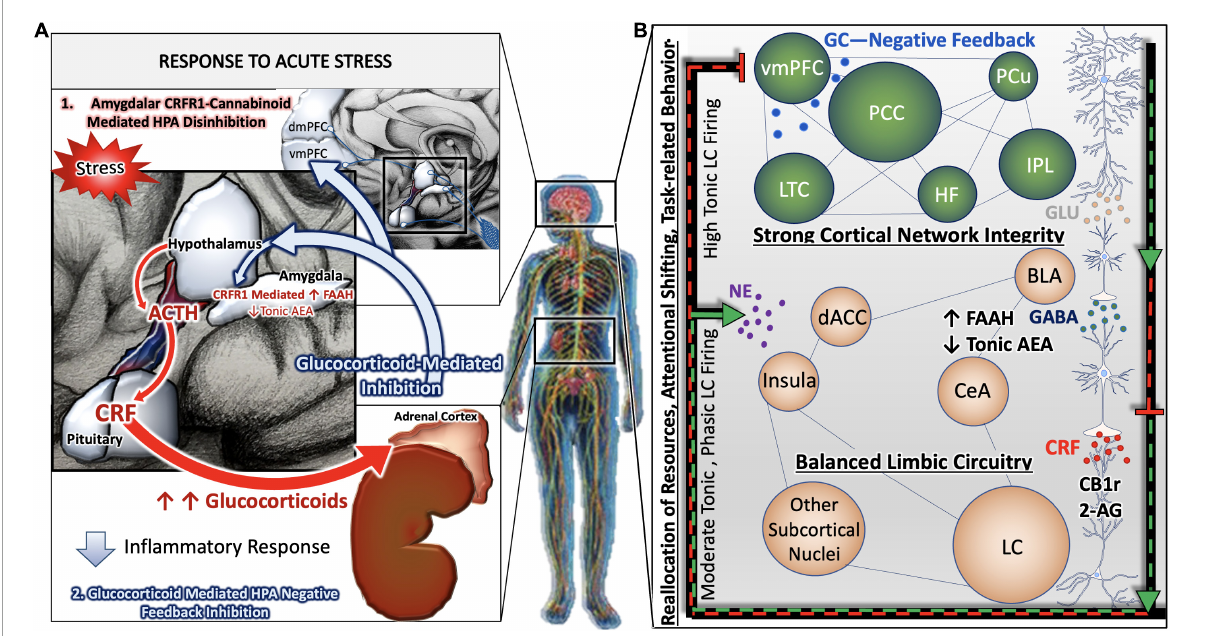
FIGURE1 Stress-integrative circuitry intact and adaptive. Under normal physiological conditions, the HPA axis is regulated by negative feedback (A) . The activation of the HPA axis and subsequent synthesis and release of glucocorticoids from the adrenal glands feed back onto anatomical substrates such as the PVN and mPFC to terminate the stress response. Peripheral, acute CRF signaling and response by the CRF Receptor 1 on immune cells suppress the immune response. In parallel, negative feedback mechanisms of the central stress-integrative circuitry are intact and allow for adaptive responses to stressful stimuli. Under acute stress, FAAH activity is upregulated and AEA levels are decreased, enabling the activation of the HPA axis (Hill et al., 2009). The transient stress induced AEA levels in the amygdala plays an important role in balancing AEA signaling (Hill et al., 2010), and suggests that AEA tonically inhibits BLA activity in the absence of stressors (Hill et al., 2011a). Based on a series of neuroanatomical and biochemical experiments, we have put forth the idea that CB 1 r is strategically localized to presynaptic terminals of CRF-containing neurons that arise in the amygdala as a mechanism of regulating input from the amygdala to the LC. The peri-LC contains a majority of excitatory synapses, while the core LC possesses mostly inhibitory synapses. This supports the idea that amygdalar CRF afferents are modulated by the eCB system to adapt to emotional stimuli during the stress response (B)